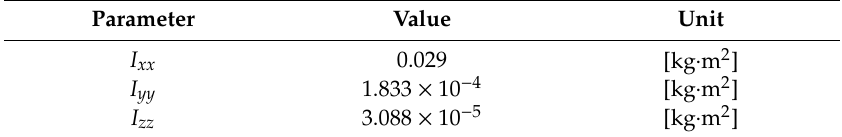
Table 2. The moments of inertia of the stand ( I ii —the moment of inertia about axis i = x , y , z ).